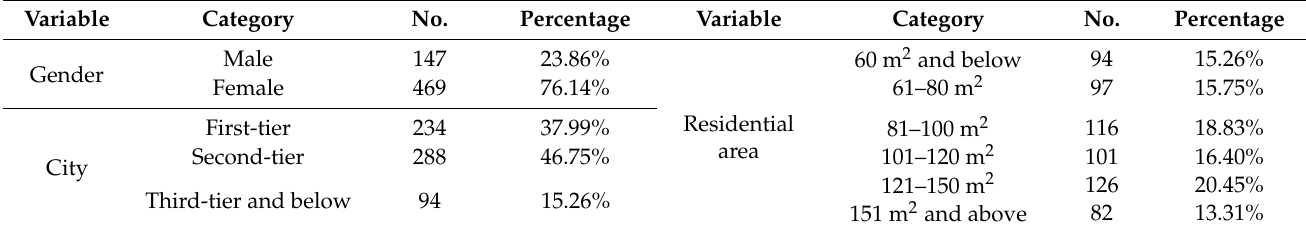
Table 1. Description of sample structure